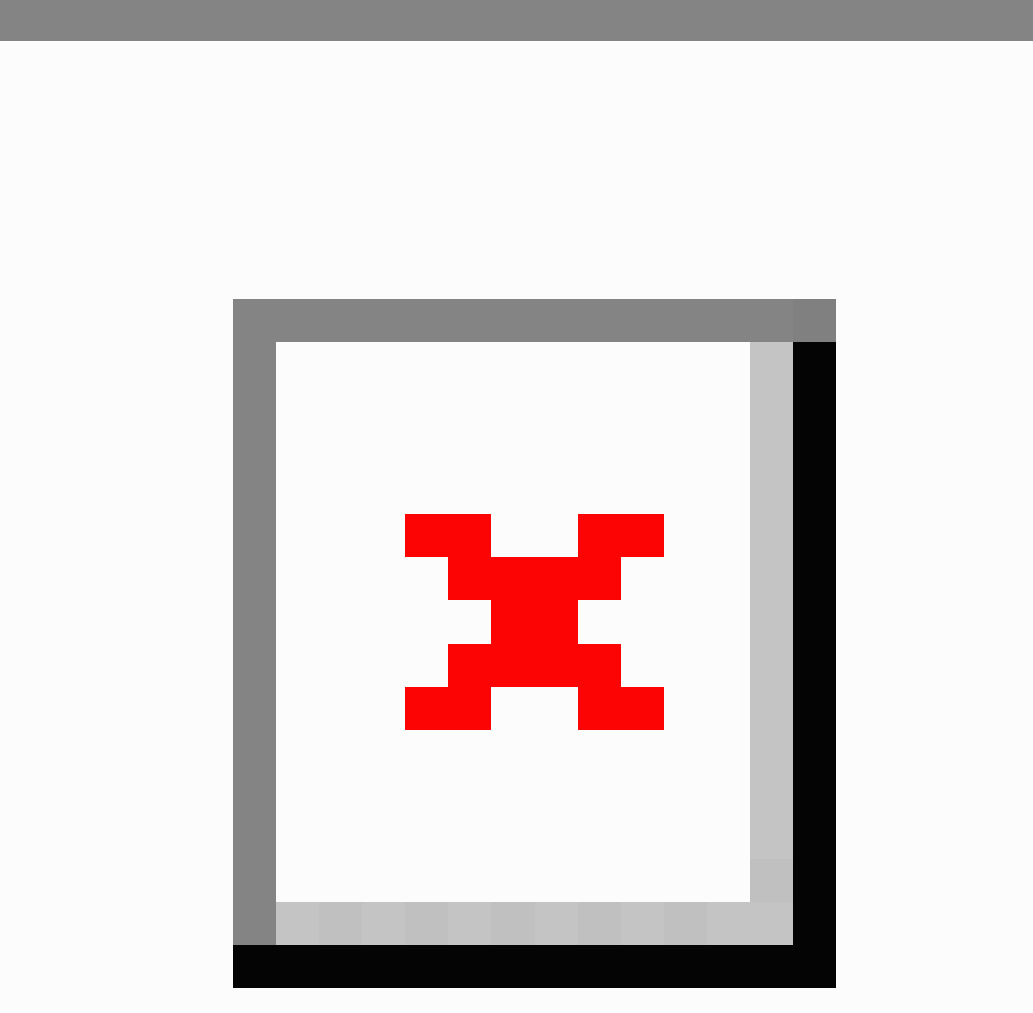
Figure 4. Screenshot of user placing a condom on a practice object in the interactive Condom Pro app. iPhone version shown on Apple iPad 2 for clarity. Reproduced with permission from Liz Sabatiuk, Social Media Manager, The National Campaign to Prevent Teen and Unplanned